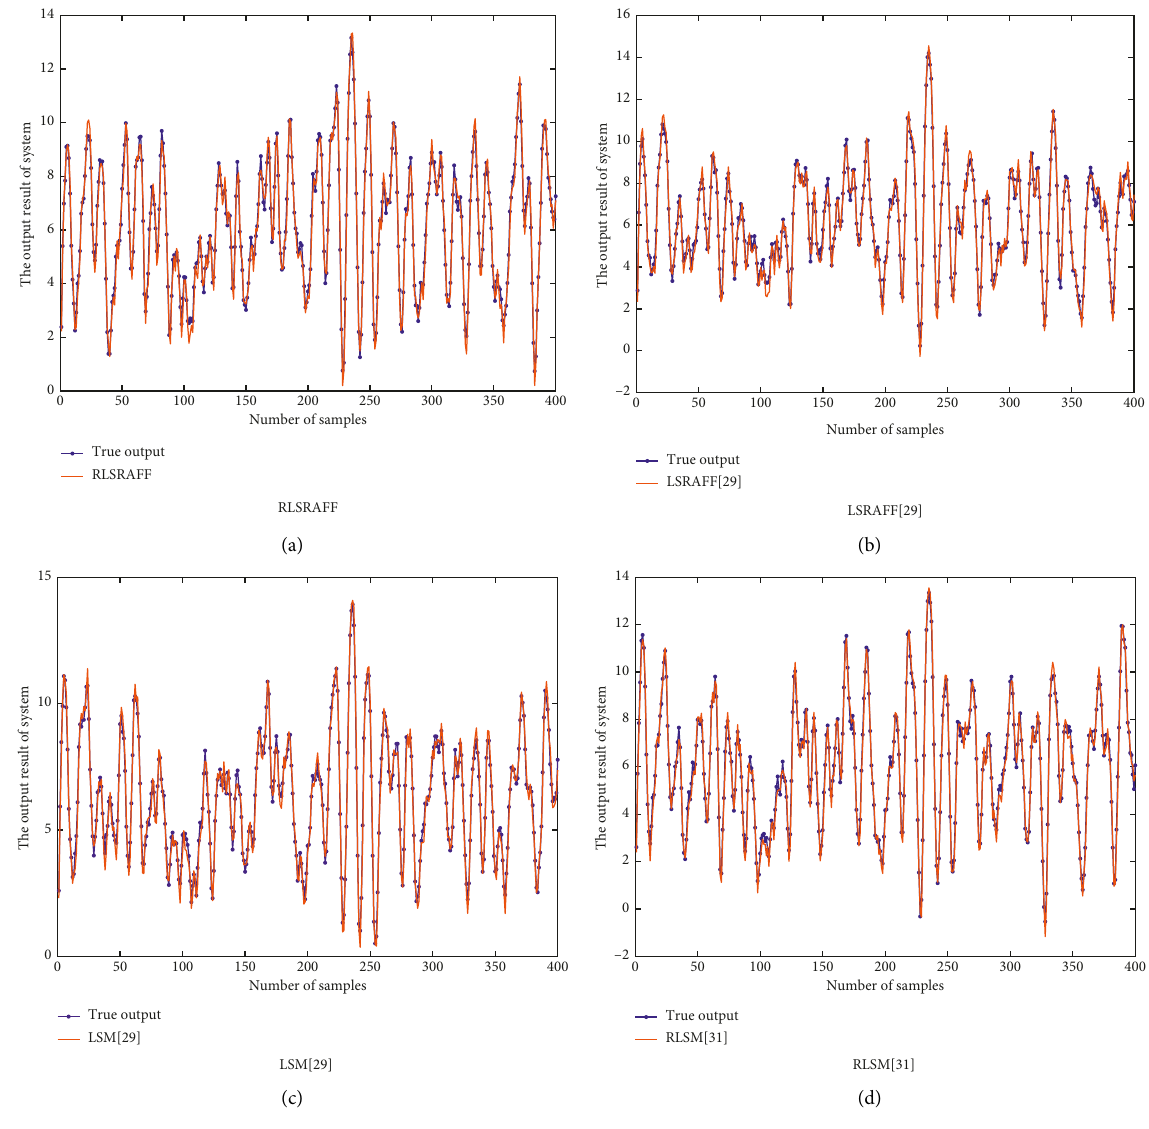
Figure 3: The output results of the